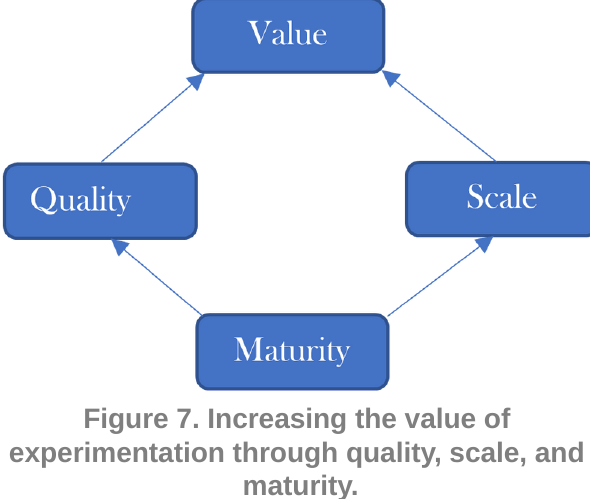
Figure 7. Increasing the value of experimentation through quality, scale, and